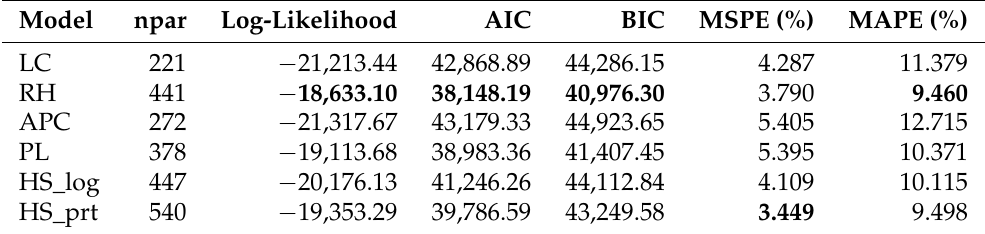
Table 7. Results of the quantitative tests for well-known stochastic mortality models against HS_prt for GR